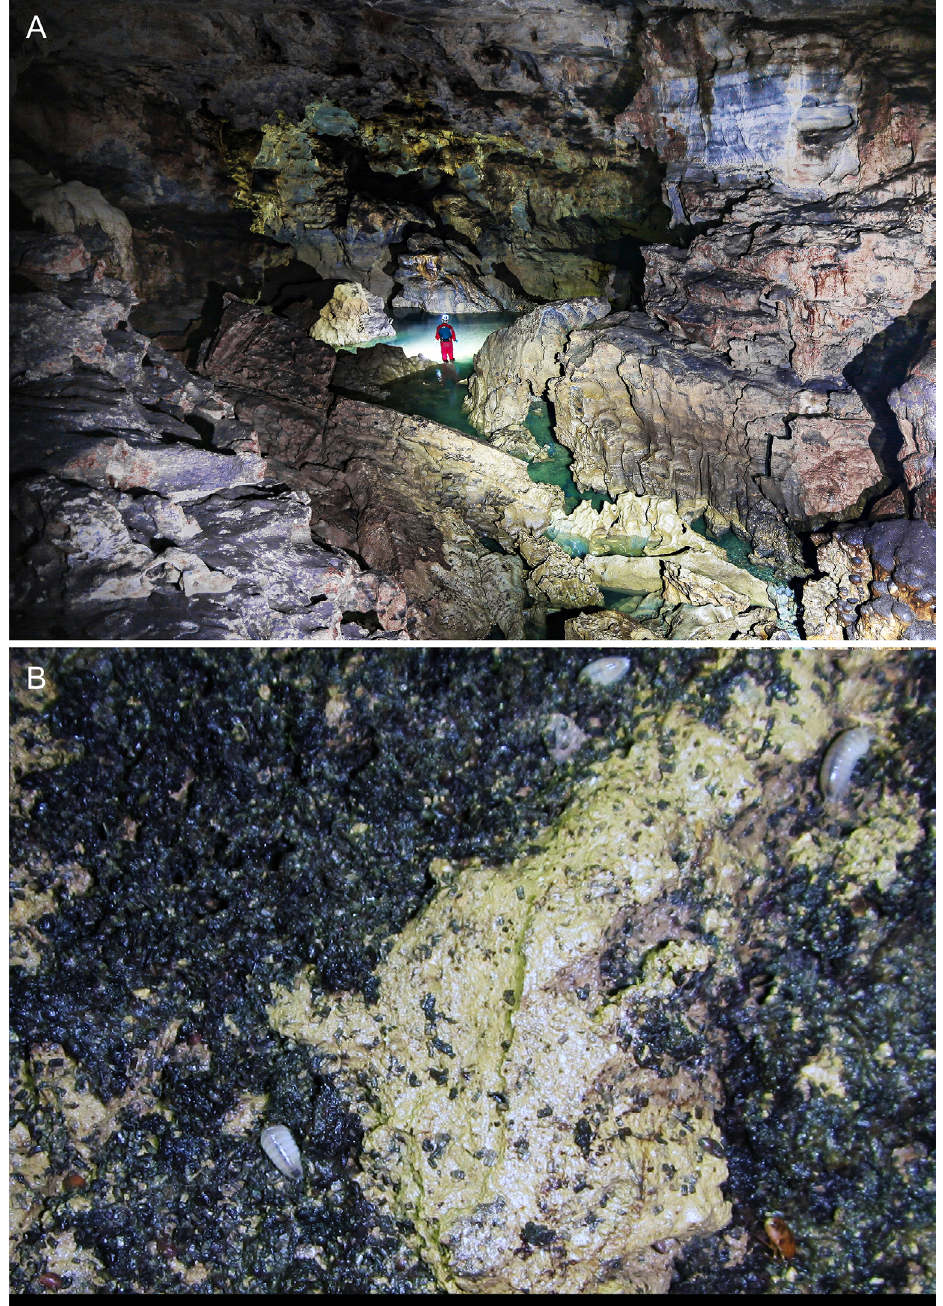
Figure 2. Cueva de Palestina. A , entrance zone of the cave , photo: A.O. Lobo; B , specimens foraging on guano on the cave